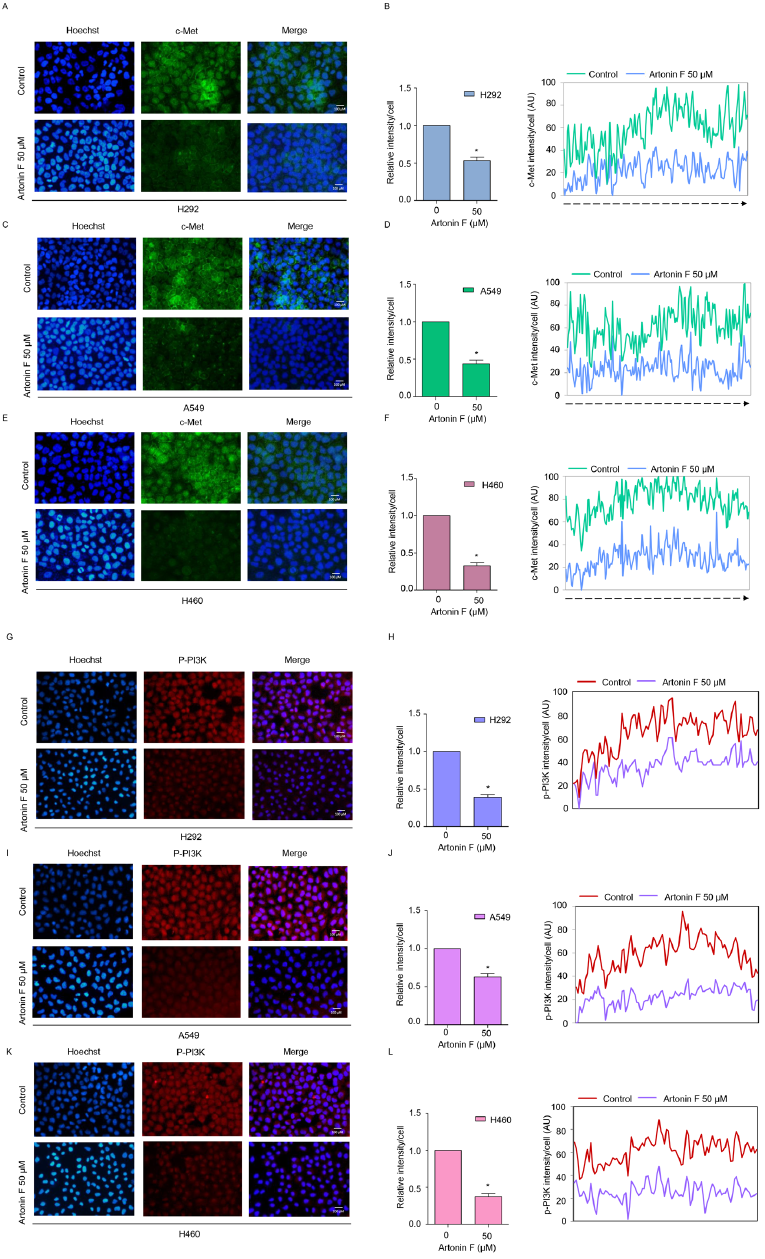
Figure 4. Artonin F decreases the levels of c-Met and p-PI3K. ( A – F ) The cells were stained with c-Met (green fluorescence) and Hoechst 33342 (blue fluorescence). The expression of c-Met was determined by immunofluorescence. ( G – L ) The cells were stained with p-PI3K (red fluorescence) and Hoechst 33342 (blue fluorescence). The expression of p-PI3K was examined using immuno- fluorescence. The fluorescence intensity was analyzed by ImageJ software. Data are shown as the mean ± SEM ( n = 3). * p < 0.05, versus the non-treated control. 2.4. Artonin F Decreases c-Met Levels through the Induction of c-Met Proteasomal Degradation Through its signaling transduction pathways, c-Met promotes cancer progression in a variety of tumors. A previous study revealed that protein turnover is influenced by